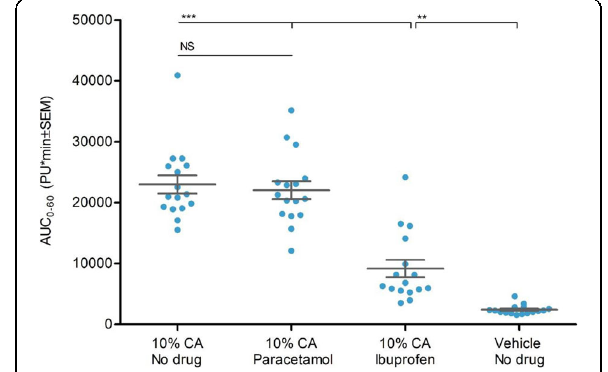
Fig. 1 (abstract P156). Influence of paracetamol and ibuprofen on the CA-induced DBF response (n = 16). One-way ANOVA with